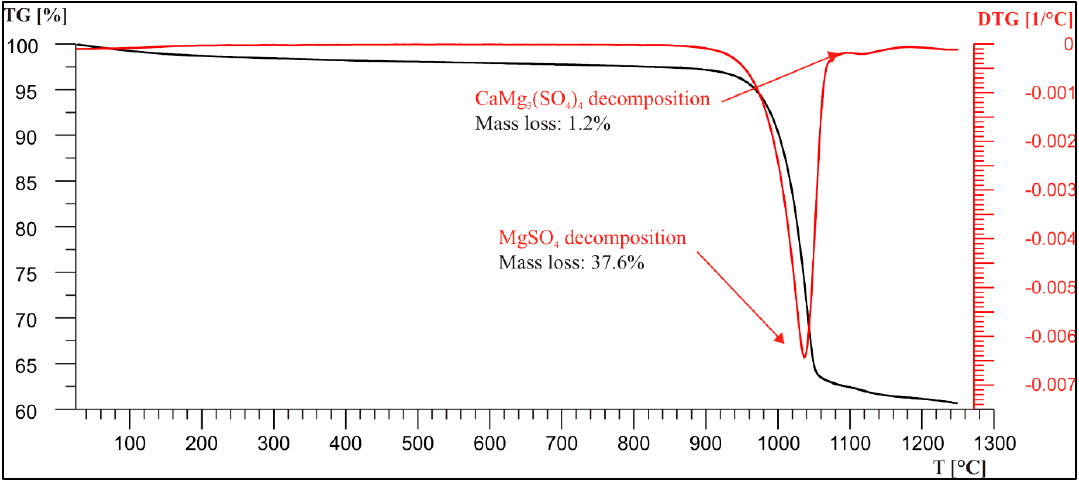
Figure 8. TG and DTG thermal curves of magnesite sulfation products from the Wiry